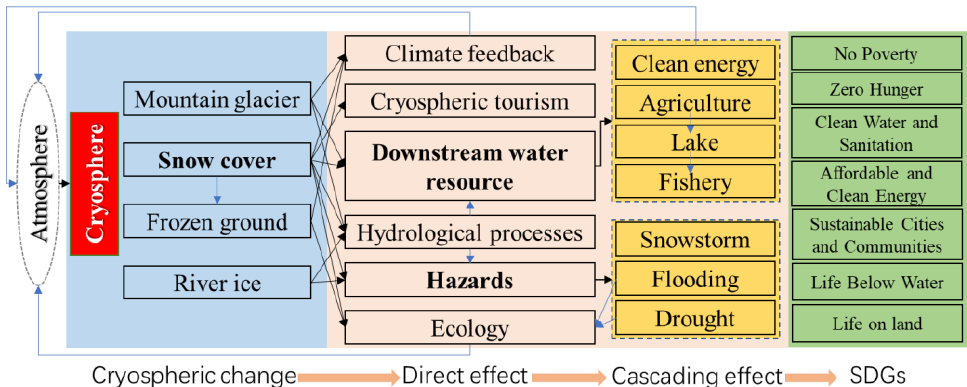
Figure 8. Direct and cascading effects of cryospheric changes and their correlation with SDGs in the SAM.